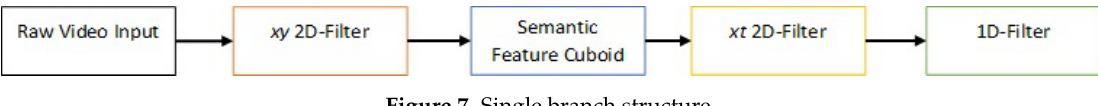
Figure 7. Single branch